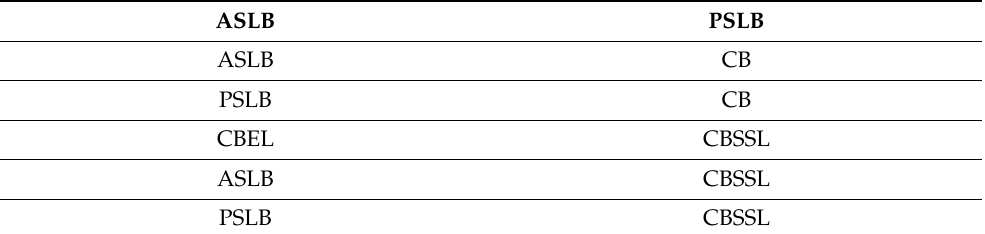
Table 2. Brackets to be compared.